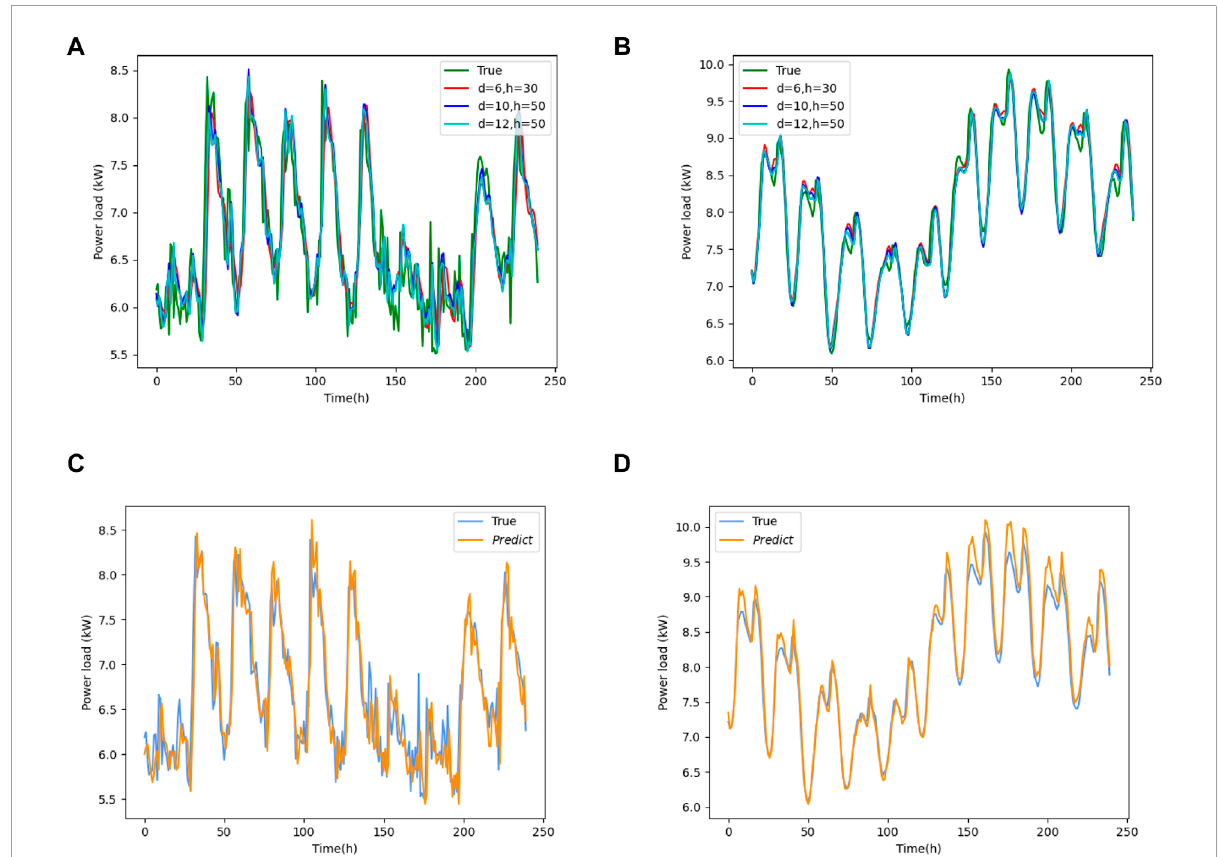
FIGURE 8 Prediction results of the FFNN model and the LSTM Model with the two Datasets. (A) Results of the FFNN model with Dataset 1. (B) Results of the FFNN model with Dataset 2. (C) Results of the LSTM model with Dataset 1. (D) Results of the LSTM model with Dataset